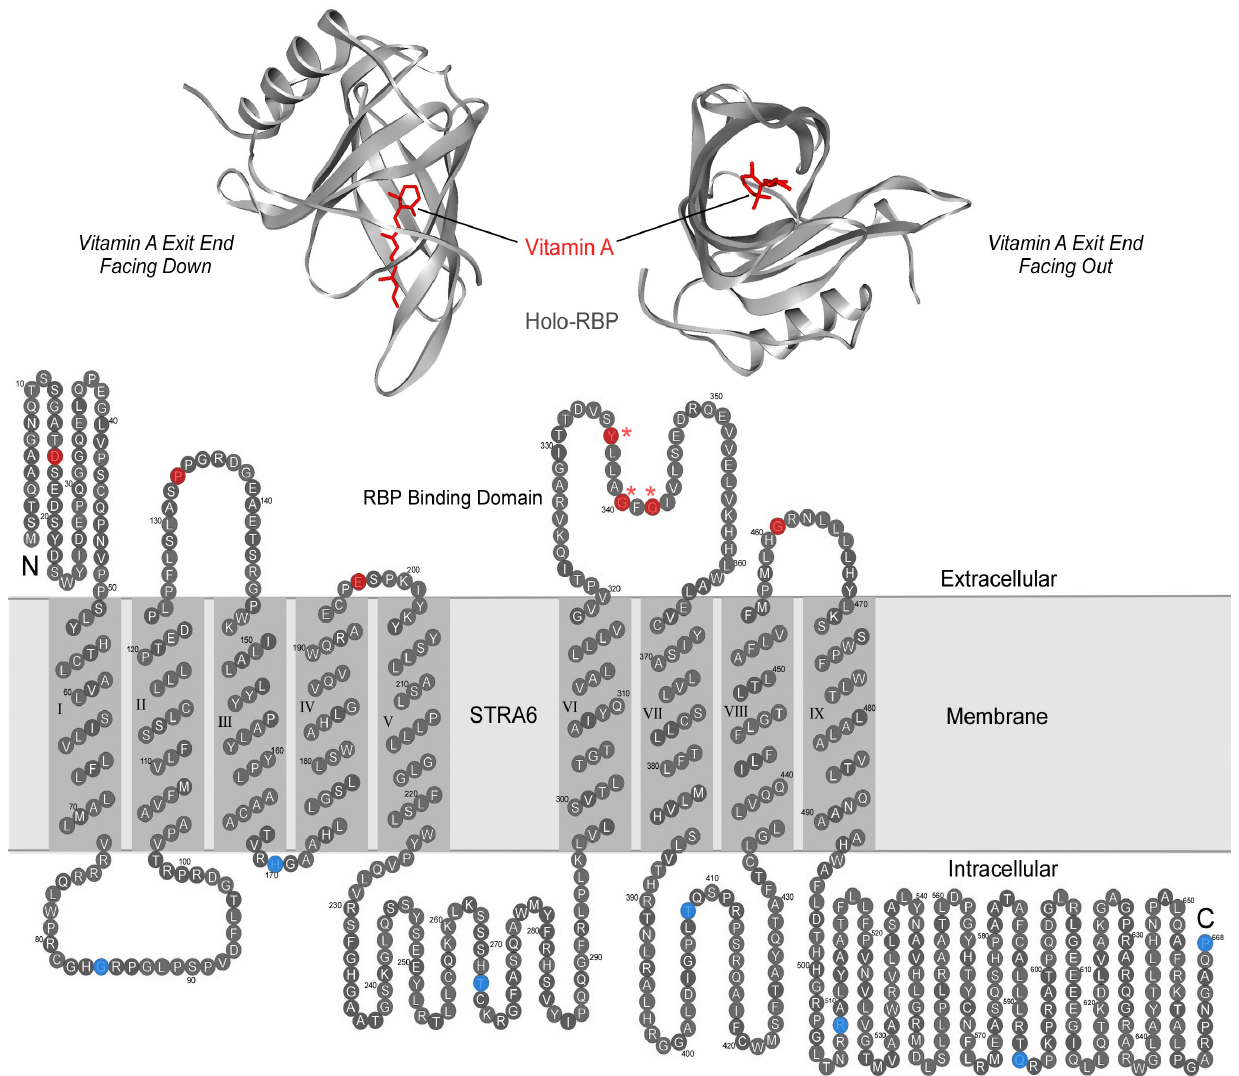
Figure 1. Plasma retinol binding protein and its transmembrane receptor STRA6. A. Crystal structures of holo-RBP with the vitamin A exit end facing down (left picture) or facing out (right picture). B. The transmembrane topology model of STRA6. Residues that have been experimentally confirmed to be extracellular are labeled in red. Residues that have been experimentally confirmed to be intracellular are labeled in blue. The three STRA6 residues essential for RBP binding are labeled with asterisks. A mutation in either one of these three residues is sufficient to abolish RBP binding and vitamin A uptake without affecting STRA6’s cell-surface